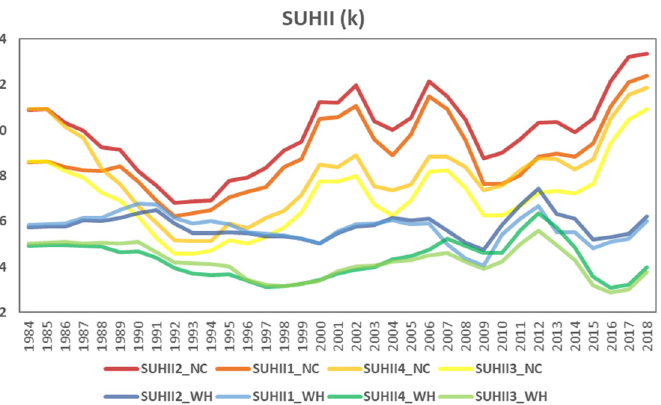
Figure 6. Temporal evolution for different SUHII trends in Nanchang and Wuhan. The suffix “_NC” represents Nanchang; the suffix “_WH” represents Wuhan.